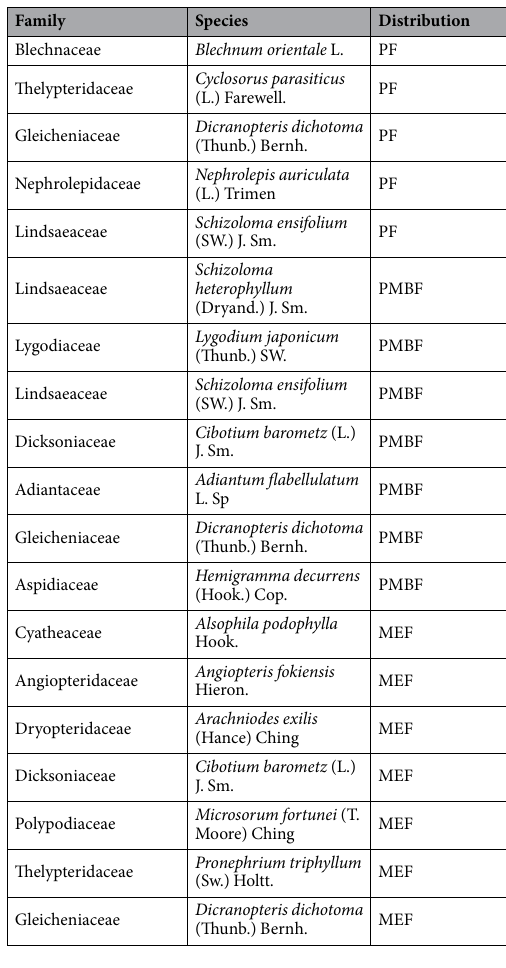
Table 2. 19 fern species found in pine forest (PF), pine and mixed broad leaf forest (PMBF) and matured broad leaf forest